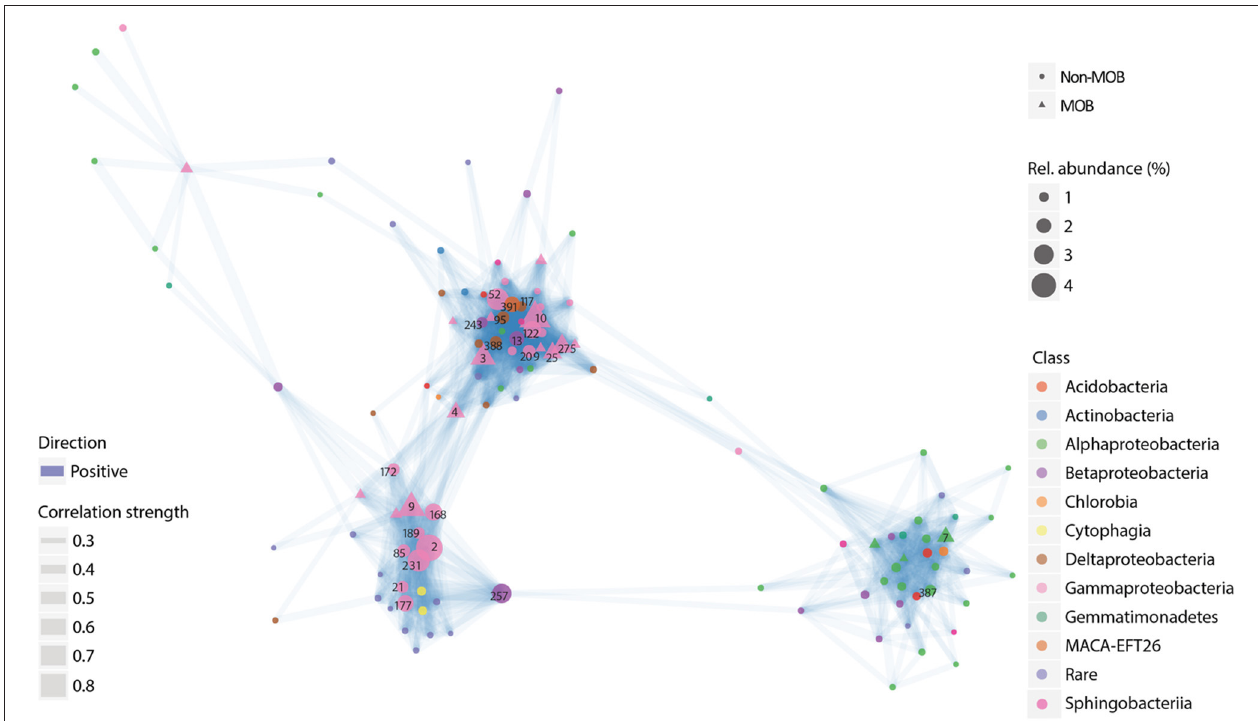
FIGURE 1 | Representative co-occurrence network of OTUs derived from 16s rRNA gene sequences. The network depicts OTUs classified as MOB together with other OTUs which significantly and positively correlated with them. The OTUs were derived from the “heavy” fraction (i.e., isotopically labeled DNA) of a SIP gradient from a 13 C–CH 4 labeling experiment of a microbial community in sediments from a geothermal spring ( Sharp et al., 2014). Only OTUs with > 10 total reads and which appeared in > 20% of the samples were taken into account. Full taxonomic affiliation corresponding to the numbers are listed in the Supplementary Information ( Table S1 ). The experimental conditions and site information are given in Table 1